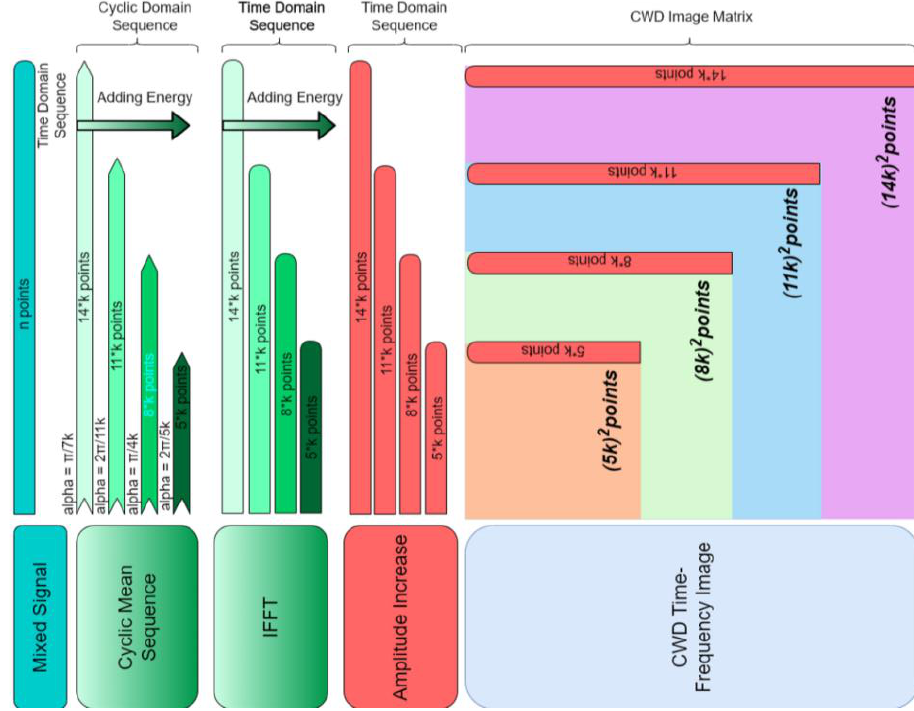
Figure 8. Preprocessing method steps and sequence length comparison diagram.